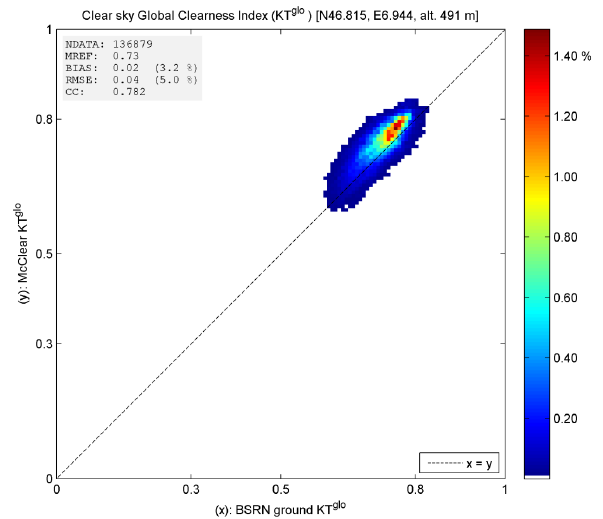
Fig. 4. Scatter density plot between BSRN 1min clear-sky data and McClear. Payerne. Global irradiance on horizontal surface.